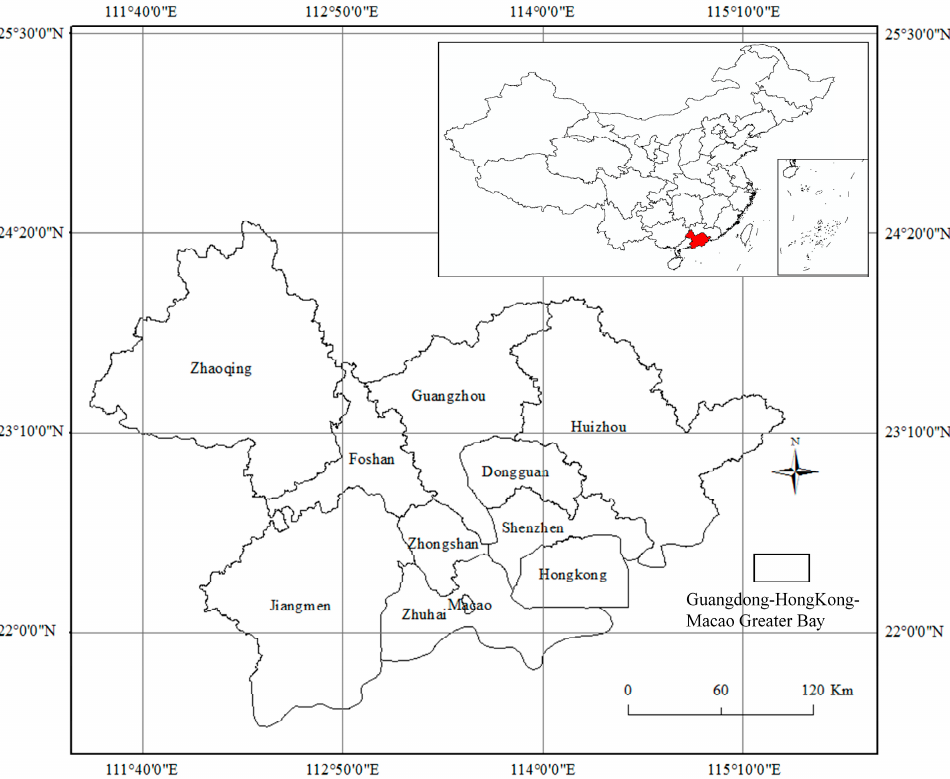
Figure 1. The location of the study area: Guangdong–Hong Kong–Macao Greater Bay. Remote Sens. 2021 , 13 , x FOR PEER REVIEW